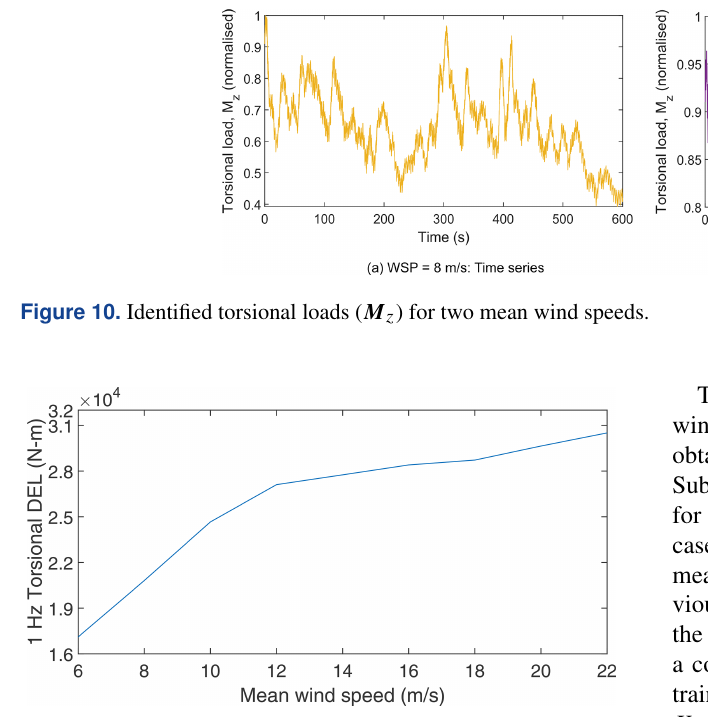
Figure 11. Estimated torsional DEL from SCADA measurements of the Vestas V52 turbine. Table 2. Normal operation filter